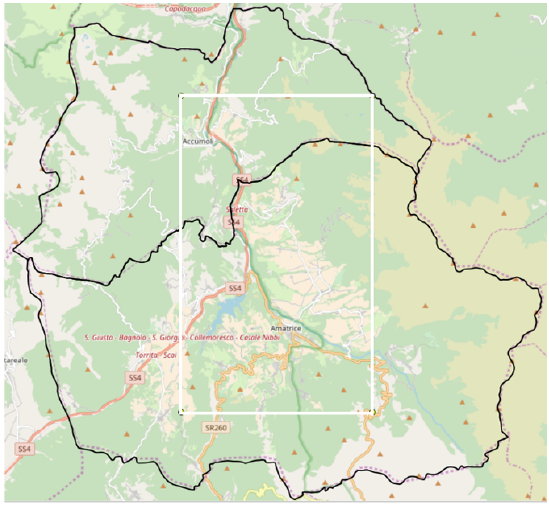
Figure 4. Area of interest and bounding box, basemap by OpenStreetMap